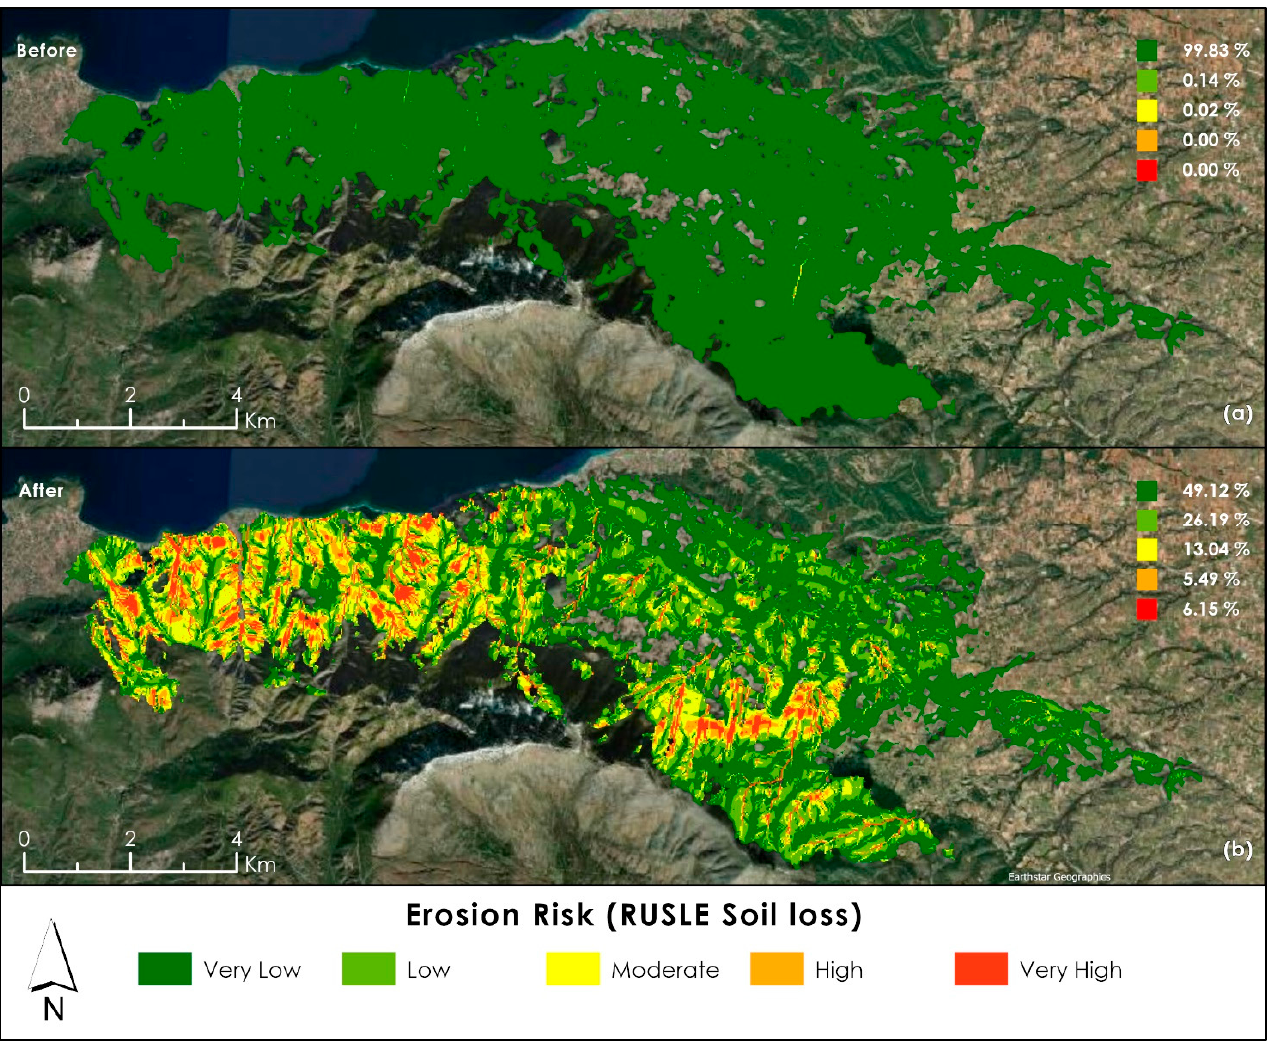
Figure 5. Erosion Risk according to RUSLE soil loss for Schinos burned area: ( a ) before the fire; ( b ) after the fire. The erosion risk as classified is presented including the percentage of the burned area total of each area per